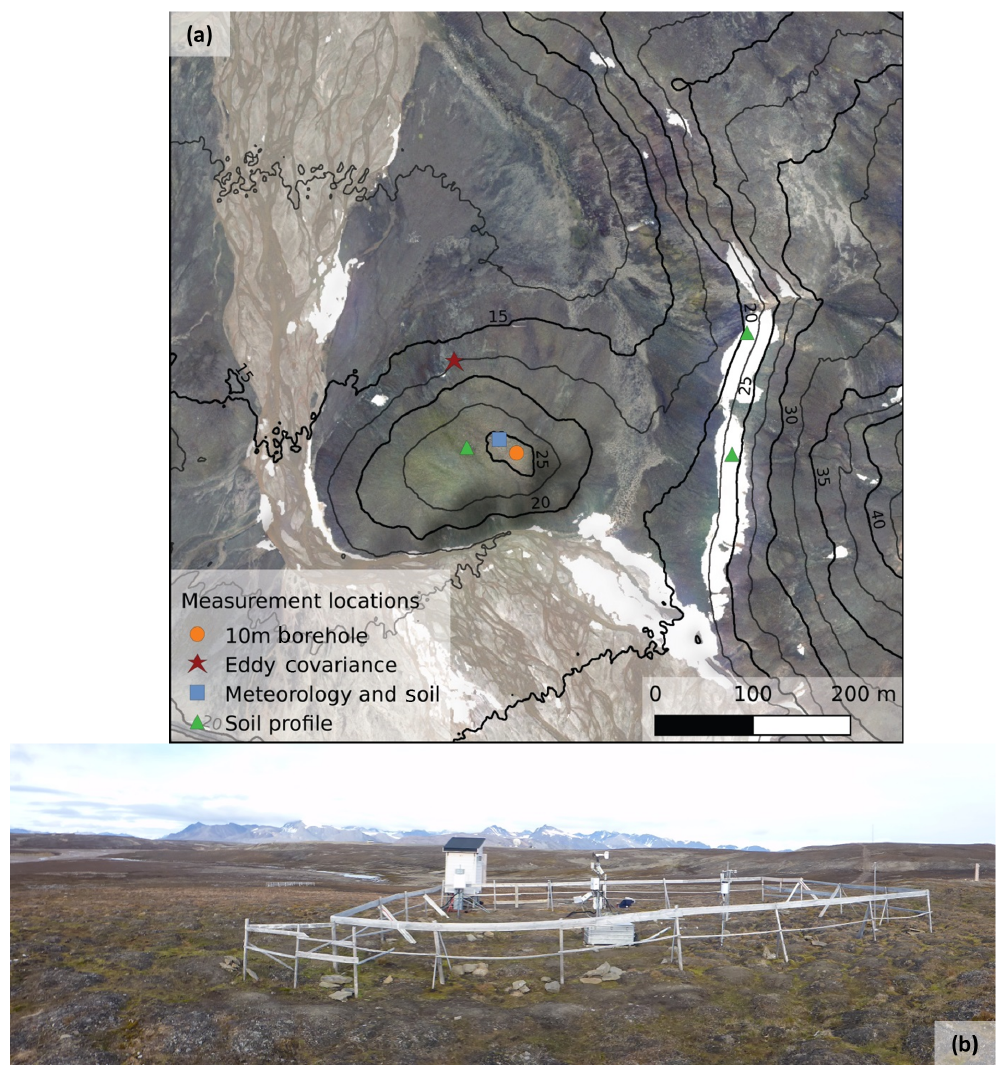
Figure 2. Topographical map (a) and overview of the Bayelva study site (b) in Ny-Ålesund, Svalbard. (a) Aerial orthoimage (20cmpx − 1 ) with topographic information (2.5m contour lines) derived from a digital elevation model (DEM) with a cell size of 0.5m. The locations of the instrumental and sampling sites are marked by colored symbols. The site is located on a small hill; white areas are snow fields remaining late in the season. The orthophoto and DEM were obtained with the HRSC-AX camera in August 2008 (data archived in Pangaea and metadata for the high-resolution DEM covering the entire area shown in Fig. 1b are provided in Appendix B). (b) Most of the instruments are within a fenced-off area to protect them from reindeer damage. Note that the eddy covariance station and permafrost borehole are located outside the fenced